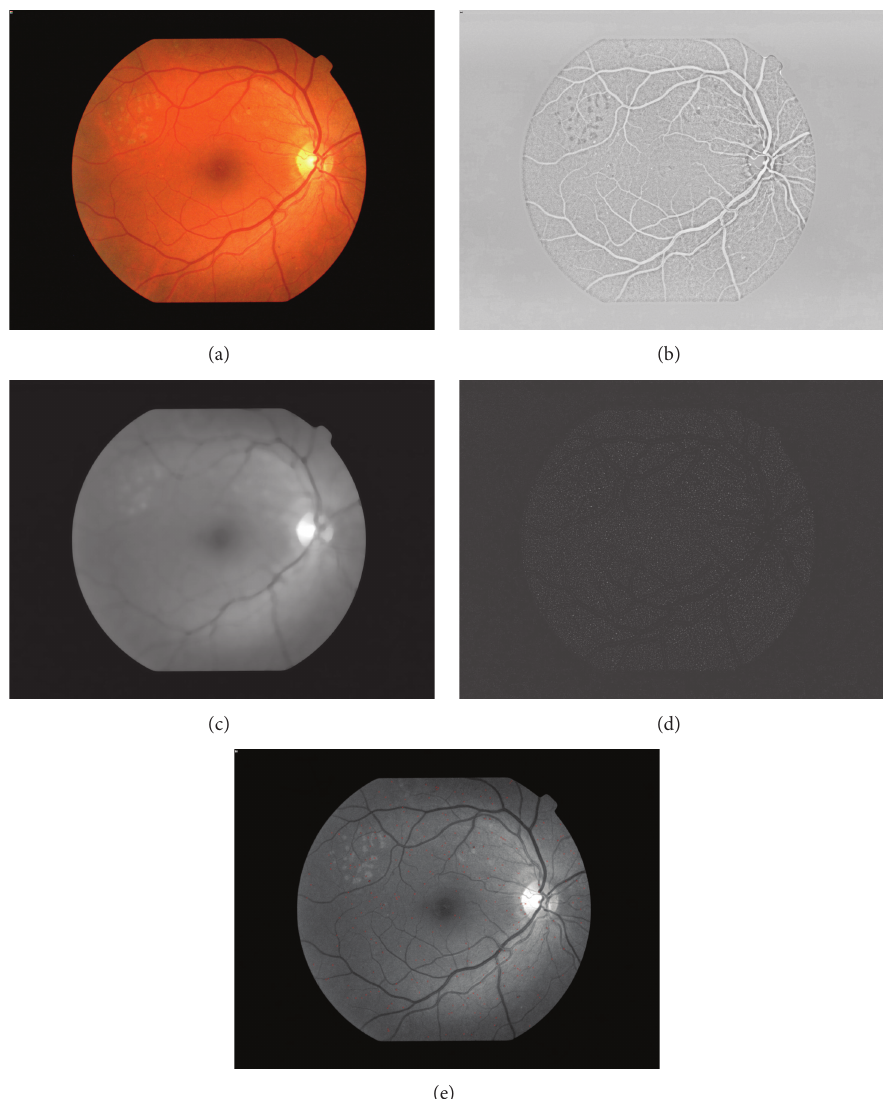
Figure 1: Microaneurysm detection. (a) Original retina image; (b) CLAHE contrast enhancement; (c) median filtering; (d) top-hat transform; (e) raw MA